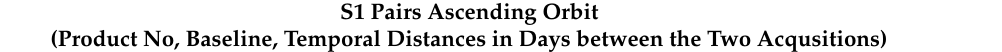
Table 3. SAR S1 images pairs adopted according to orbit in Table